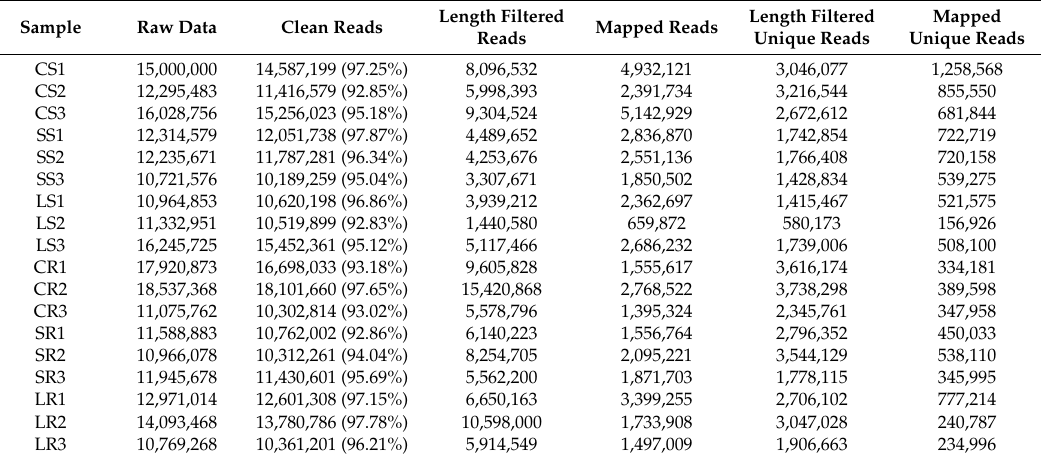
Table 1. Deep sequencing reads for sRNAs of P. euphratica stems and